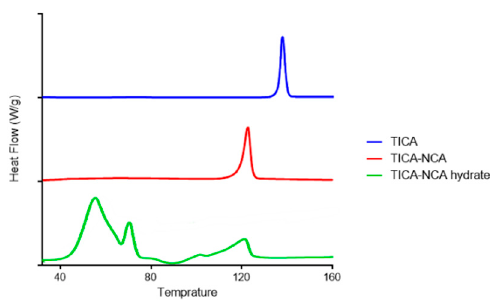
Figure 3. DSC profile of TICA, TICA-NCA, and TICA-NCA hydrate.